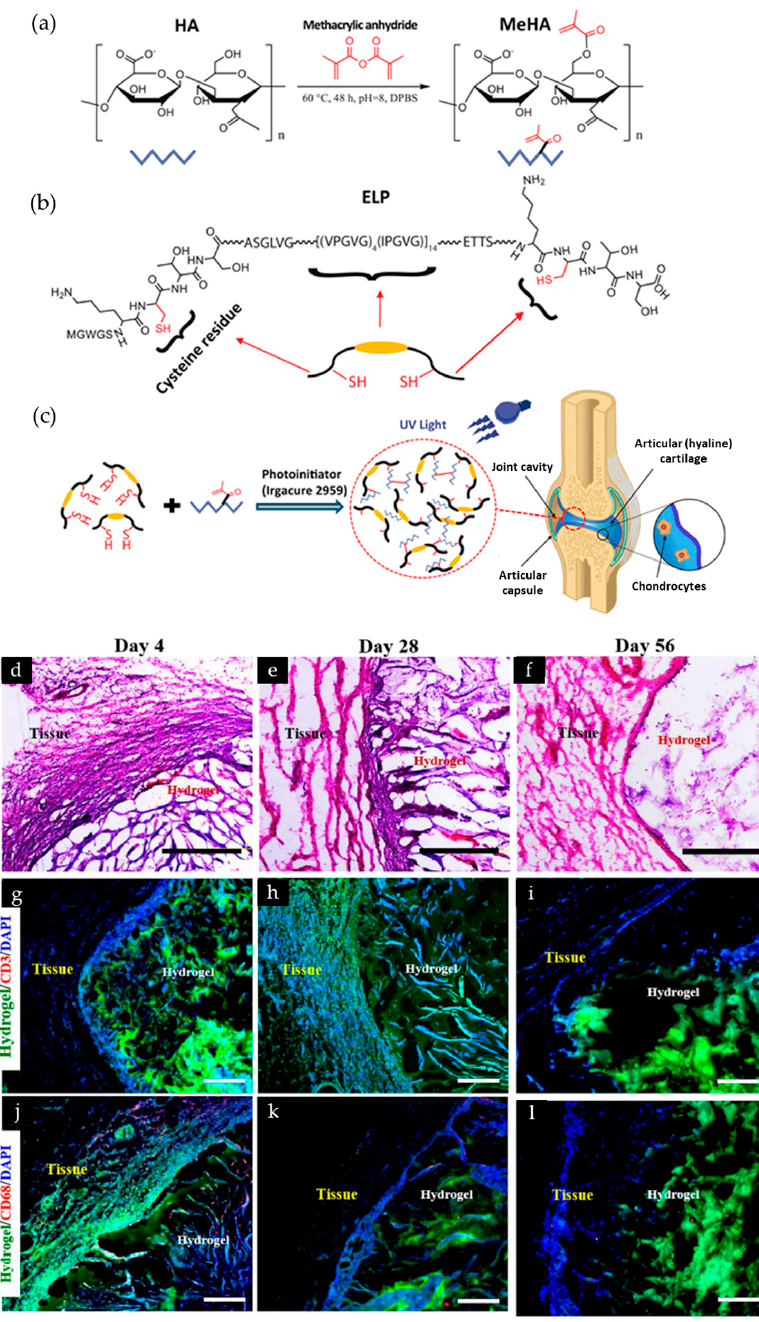
Figure 2. Schematic of methacrylated hyaluronic acid(MeHA)/elastin-like polypeptides(ELP) chem- ical structure. ( a ) HA methacrylation to form MeHA; ( b ) chemical structure of ELP; ( c ) schematic diagrams of photo-cross-linking of MeHA/ELP hydrogels and potential application as the adhesive composite. ( d – i ) In vivo biocompatibility and biodegradation of MeHA/ELP hybrid hydrogels in